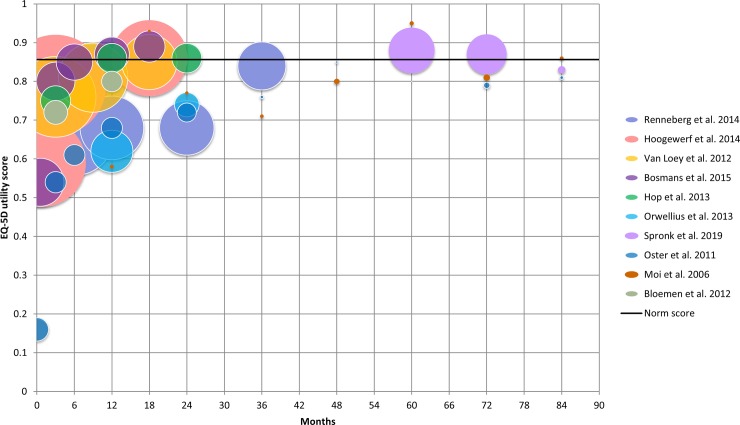
Raw outcomes of the different studies.The size of the bubble represents the number of outcomes within a study on a specific time point.